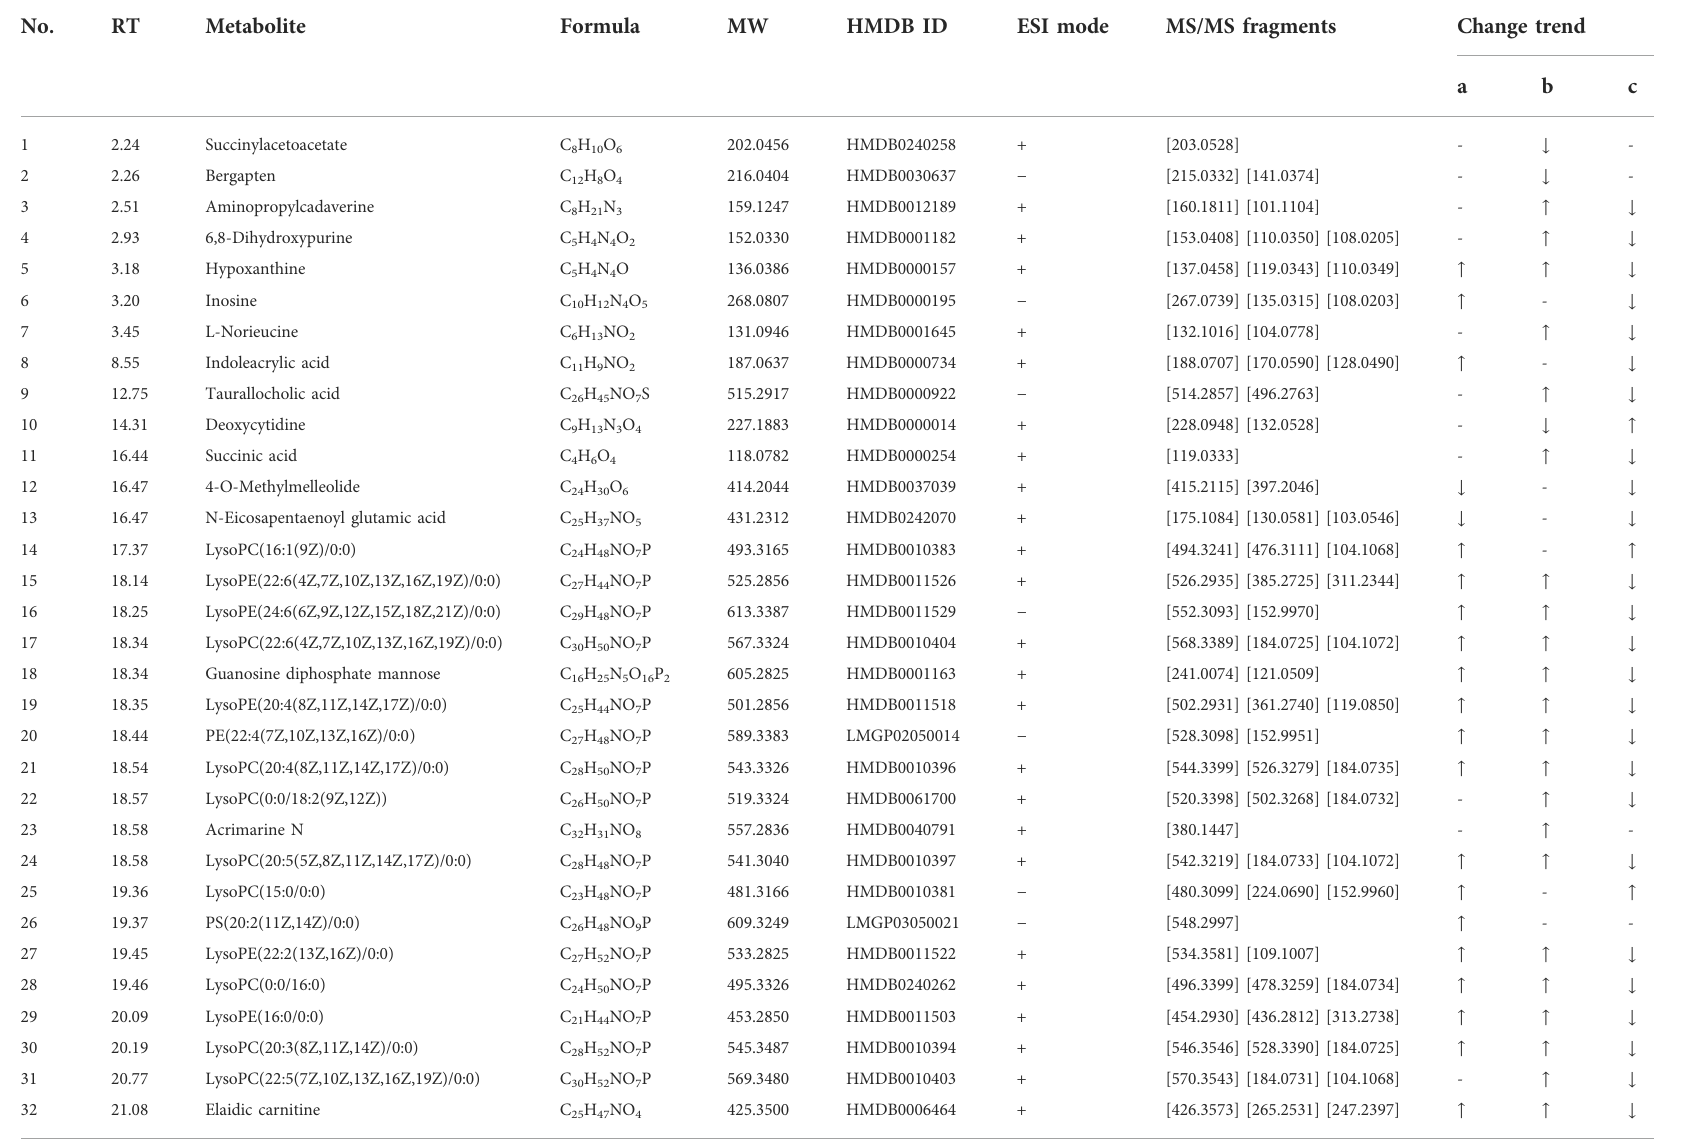
TABLE 1 Representative differential metabolites in serum of control, model and CuB group.